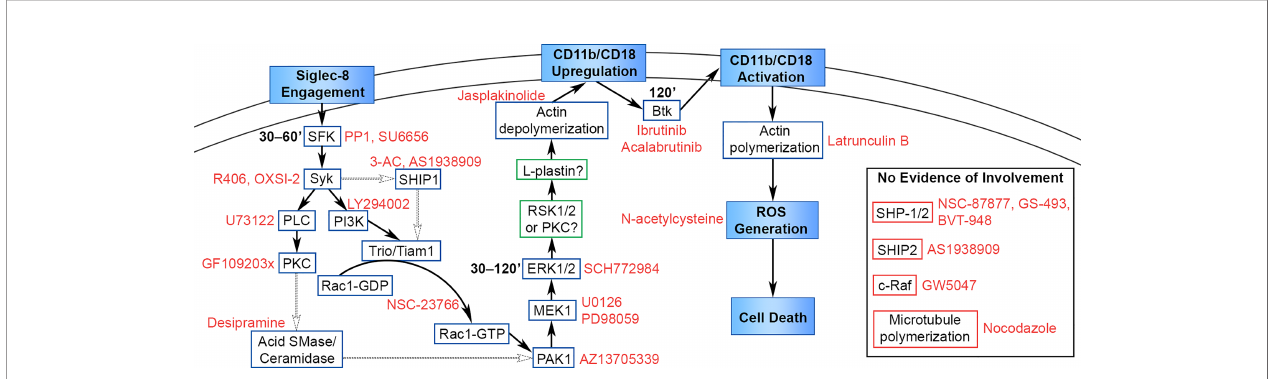
FIGURE 8 | Proposed signaling pathway leading from Siglec-8 engagement to eosinophil cell death. Cellular events that occur in the cell death process are named in fi lled boxes. Positively identi fi ed signaling molecules are placed in boxes outlined in blue, candidate molecules that may be involved in the pathway are placed in boxes outlined in green, and molecules that do not appear to be involved in the pathway are placed in boxes outlined in red. Pharmacological inhibitors are named in red text adjacent to their molecular target, and the timing of signaling molecule activation is added in bold text adjacent to SFK, ERK1/2, and Btk. The data in this study identify and place molecules necessary in this pathway upstream or downstream of the named cellular events in the diagram. The precise sequence of molecules is hypothetical based on the literature, with well-supported interactions indicated with solid arrows and possible interactions indicated with dotted